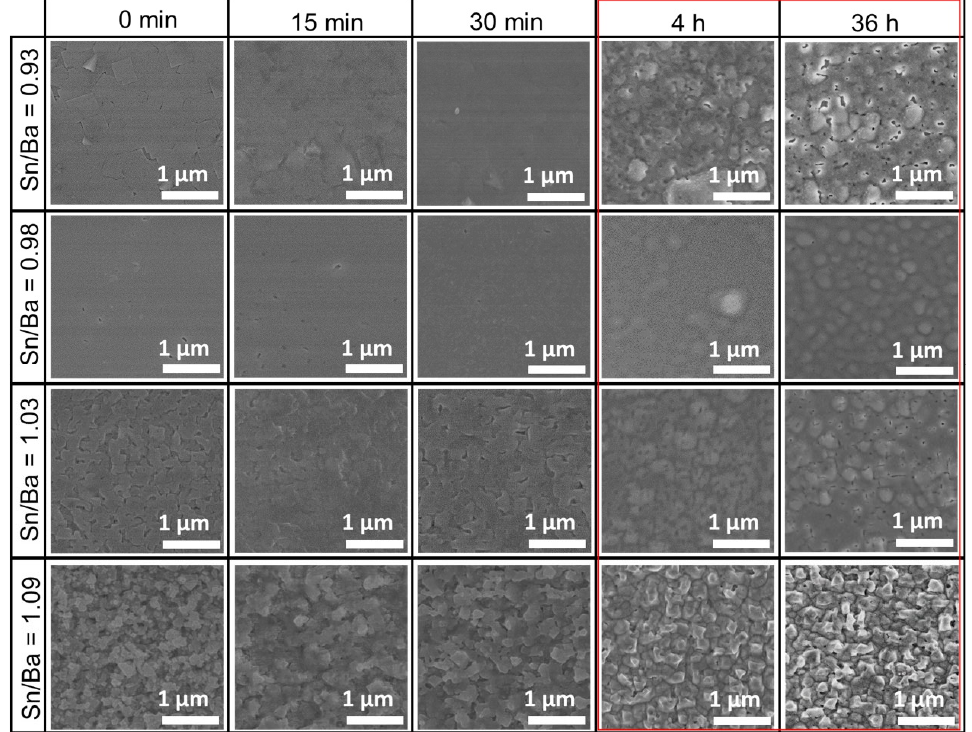
Figure 2. SEM morphology evolution of thin La-doped barium stannate films deposited on SrTiO 3 (001) substrates. Samples were annealed at 900 °C for different durations. Each column represents durations of as-deposited, 15 min, 30 min, 4 h, and 36 h. Each row represents a different initial Sn/Ba molar ratio of the samples corresponding to 0.93, 0.98, 1.03, and 1.09. The red box marks the most significant changes in the LBSO films’ morphology.